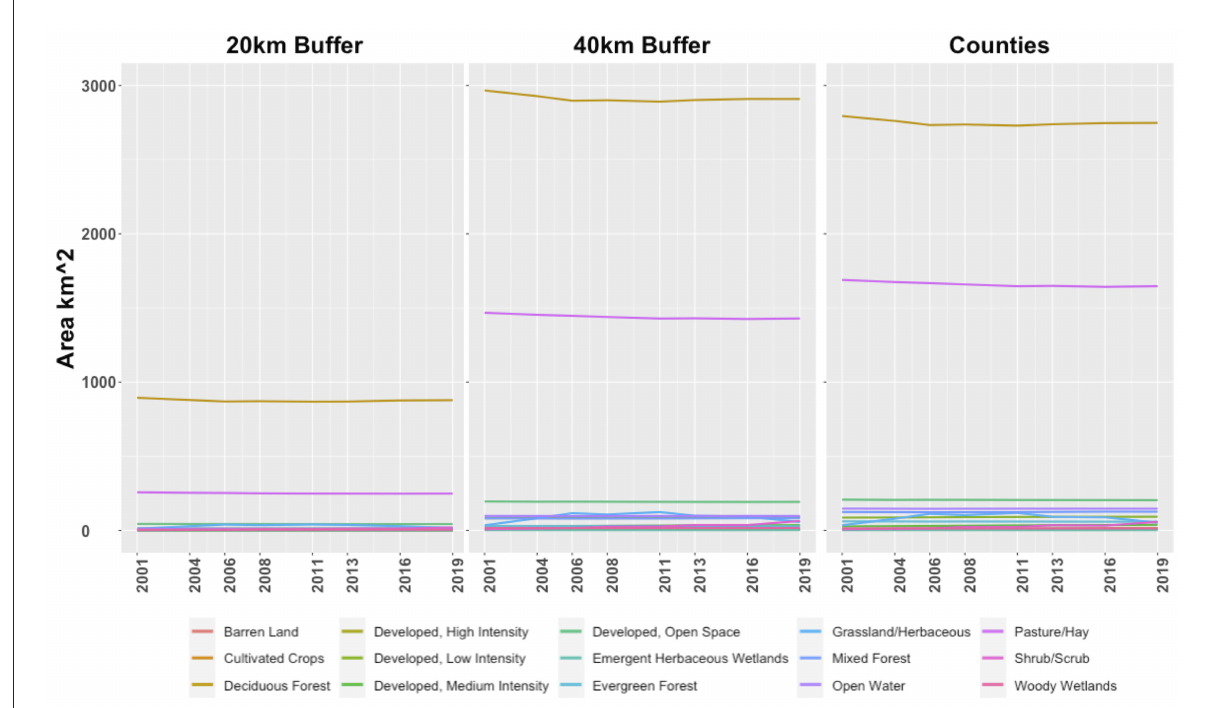
FIGURE7 Land class surface areas calculated from NLCD data from 2001 to 2019. Land use classifications are consistent with the NLCD naming convention. The (left) plot depicts land class trends within a 20km buffer surrounding Mary Lawson Cave; the (center) plot depicts trends within a 40km buffer; the (right) plot depicts trends within the combined area of Camden, Dallas, and Laclede Counties. Note that the majority of land use is dominated by deciduous forest (gold) and pasture (dark pink). The remaining land classes do not individually exceed 210 km 2 of surface area, and thus are somewhat obscured due to overlap in the